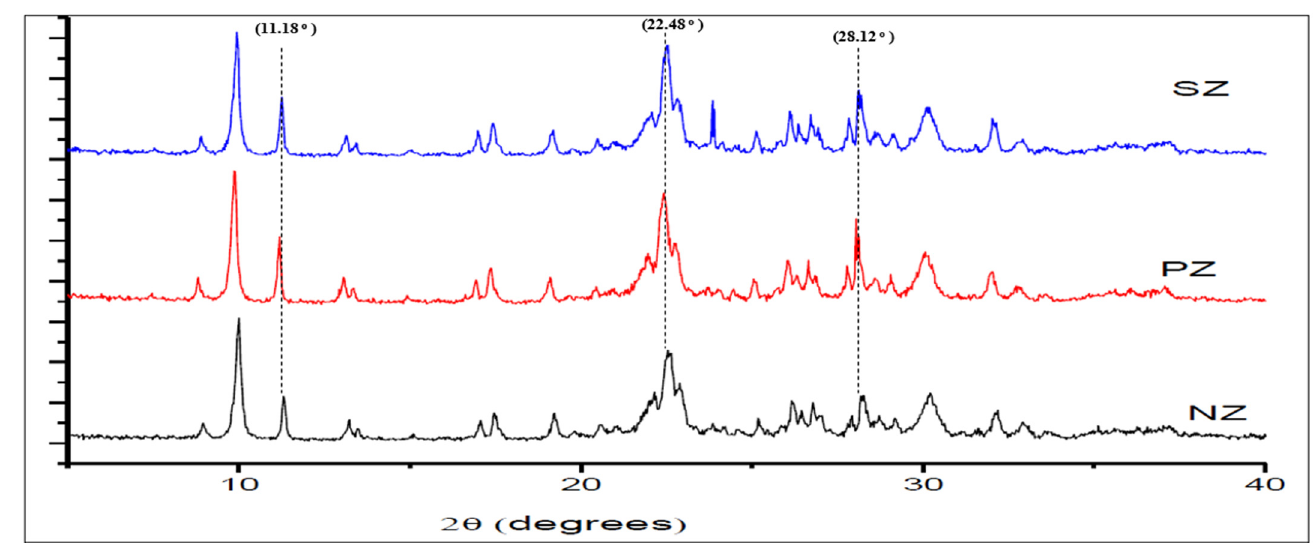
Figure 4. The close-up X-ray diffraction (XRD) patterns of NZ, PZ, and SZ after several washings with deionized water.